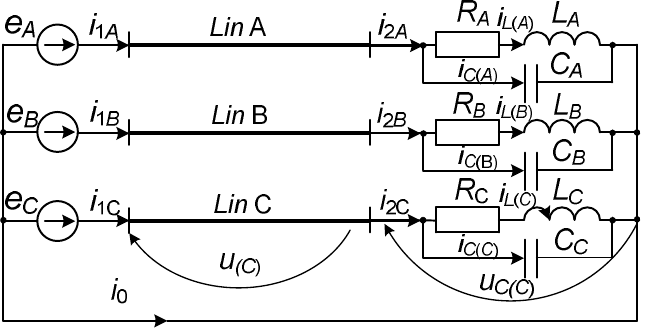
Figure 2. Circuit diagram of the electric power system.